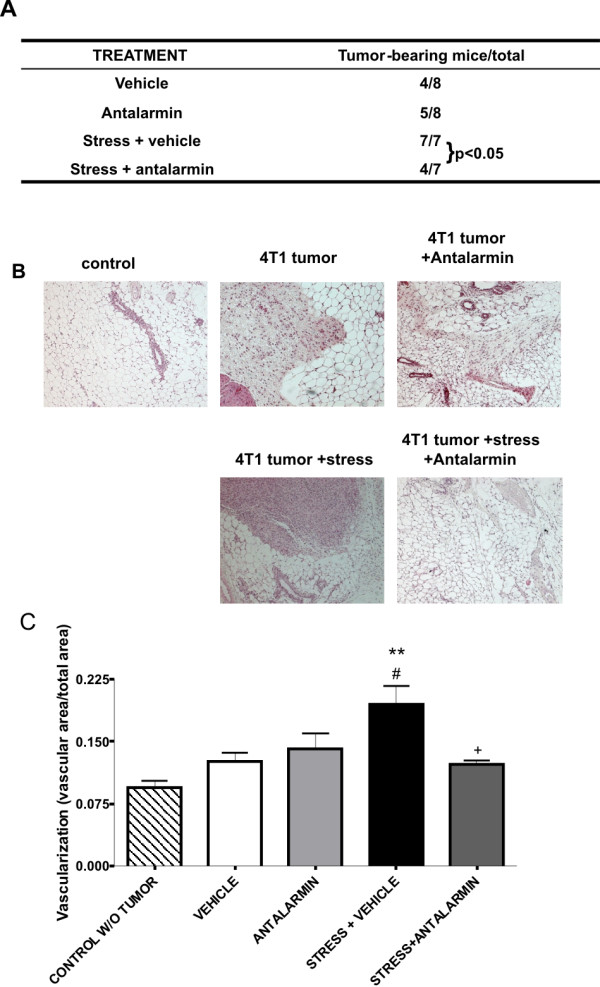
Peripheral CRF increased tumor growth and neoangiogenesis in vivo. An in vivo model of breast tumor and restraint stress was used and the percentage of tumor bearing mice and the extend of neoangiogenesis were determined as described in Materials and methods. (A) Peripheral administration of antalarmin diminished the stress-induced increase of the percentage of tumor bearing mice. (B) Representative pictures of the histological analysis. (C) The area of vascularization is increased in animals exposed to stress but this effect is abolished by the inhibition of peripheral CRF by the ip administration of antalarmin. ** p < 0.01 compared to control without tumor. # p < 0.05 compared to tumor-bearing mice injected with vehicle. + p < 0.05 compare to tumor-bearing mice exposed to stress and injected with vehicle.